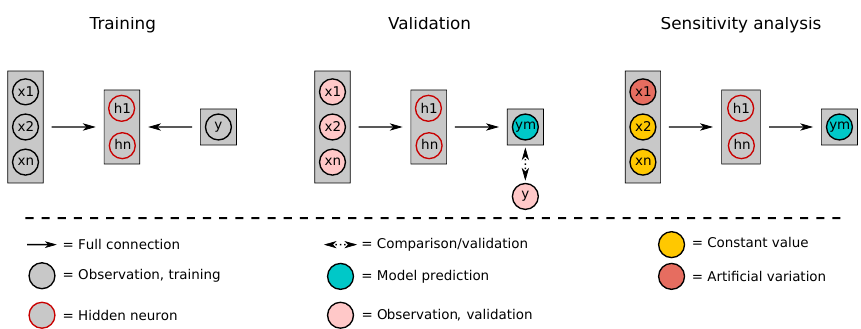
Figure 1. A schematic view of the general architecture and design of multilayer perceptron artificial neural networks. In this study, the ANN features a single hidden layer with five